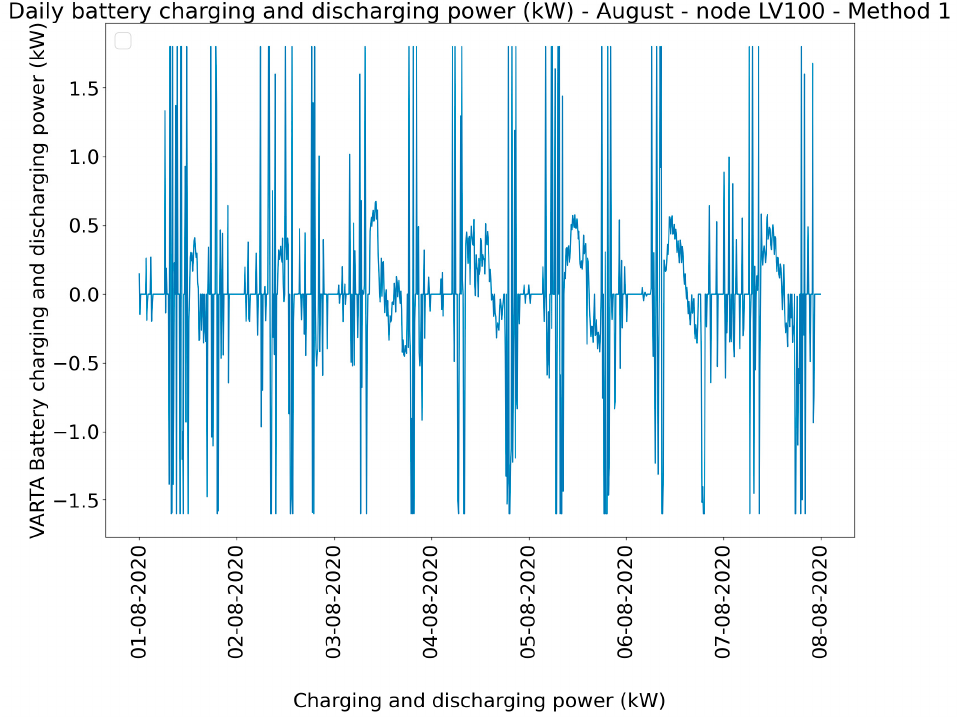
Figure A5. VARTA battery charging and discharging curve—January—Method 1.